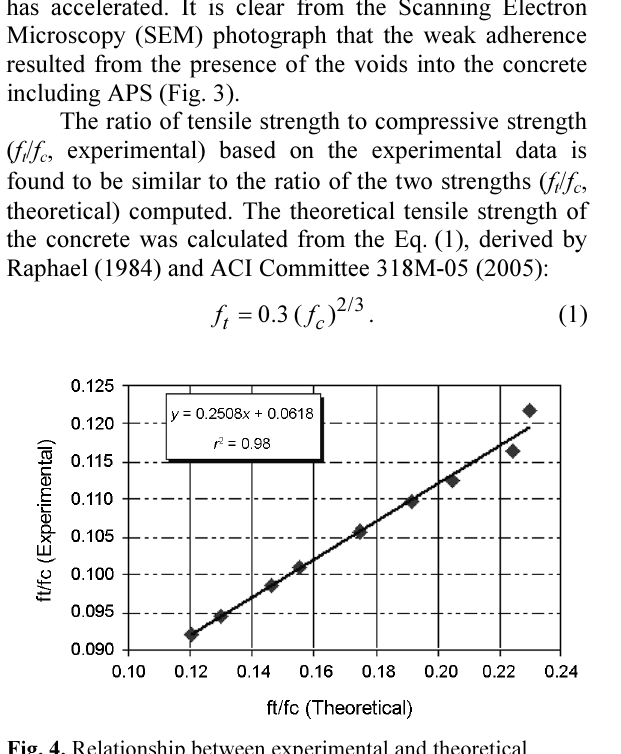
Fig. 4. Relationship between experimental and theoretical results Table 3. Parameters of the proposed models for concrete